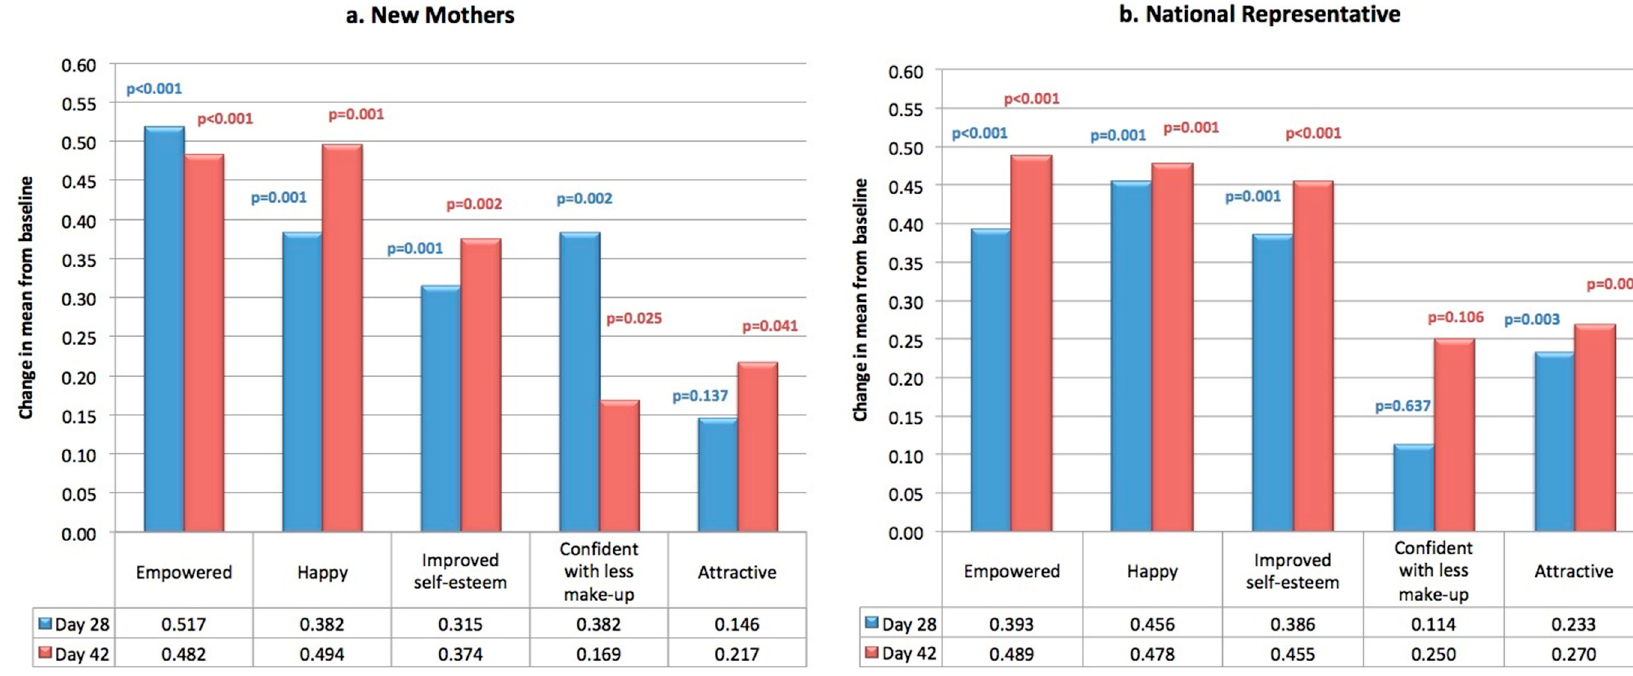
Figure 1. In a study of a three-part skin care regimen, participants were asked to fill out a Skin Care Module consisting of five questions that was included as a part of the FQoL™ instrument. Mean scores for each item were determined at three time points: before study commencement (i.e., baseline), after a 4-week usage period (day 28), and after 2-weeks of product deprivation (day 42). The 28- and 42-day mean changes from baseline are shown. The change in the response for each individual item was evaluated for statistical significance using a non-parametric Wilcoxon signed rank test. The 2-tailed p values are reported. ( a ) New Mothers group, and ( b ) National Representative group.